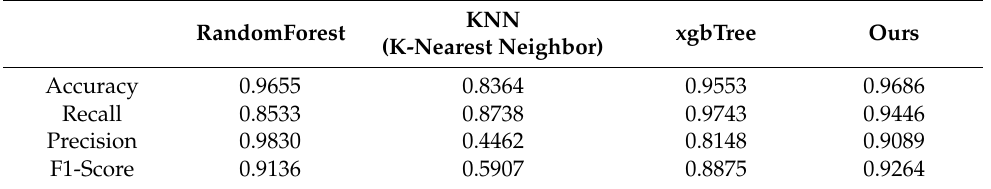
Table 4. Results of the performance